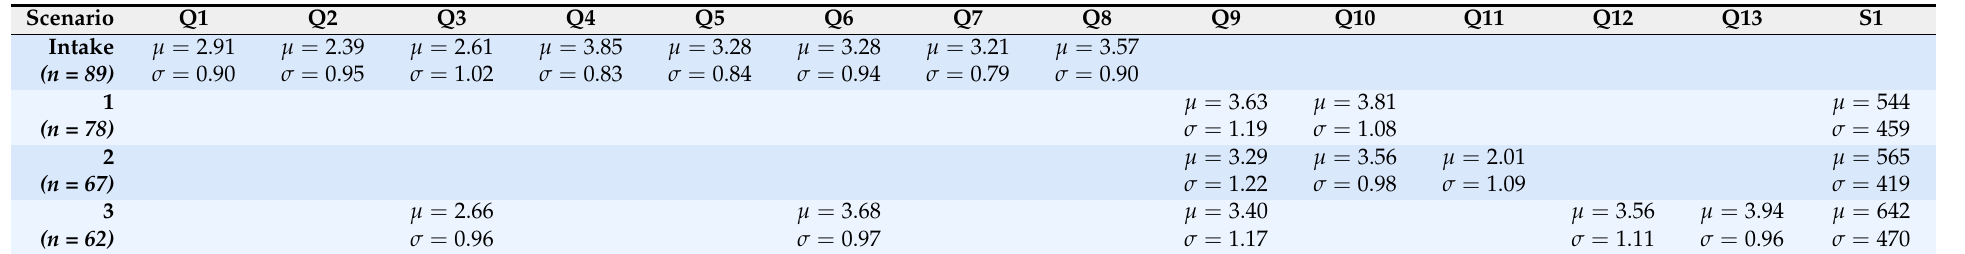
Table 2. Summarized results from the intake survey and simulator scenarios 1–3.